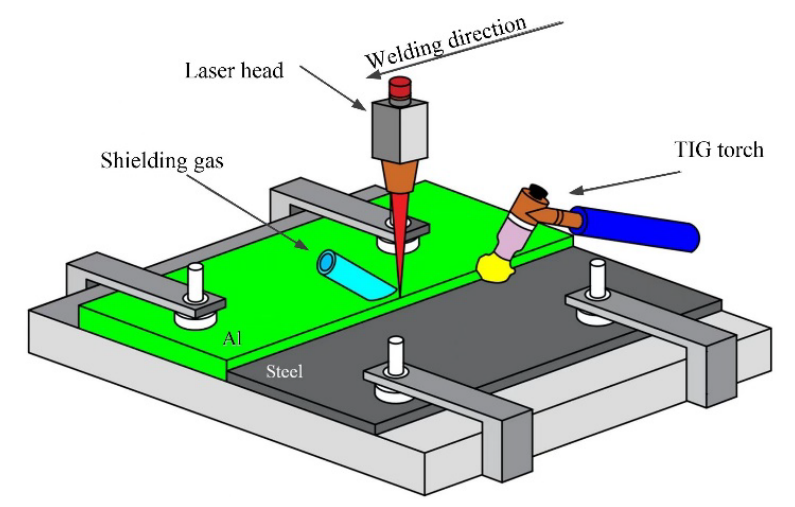
Figure 1. Sketch of welding setup.